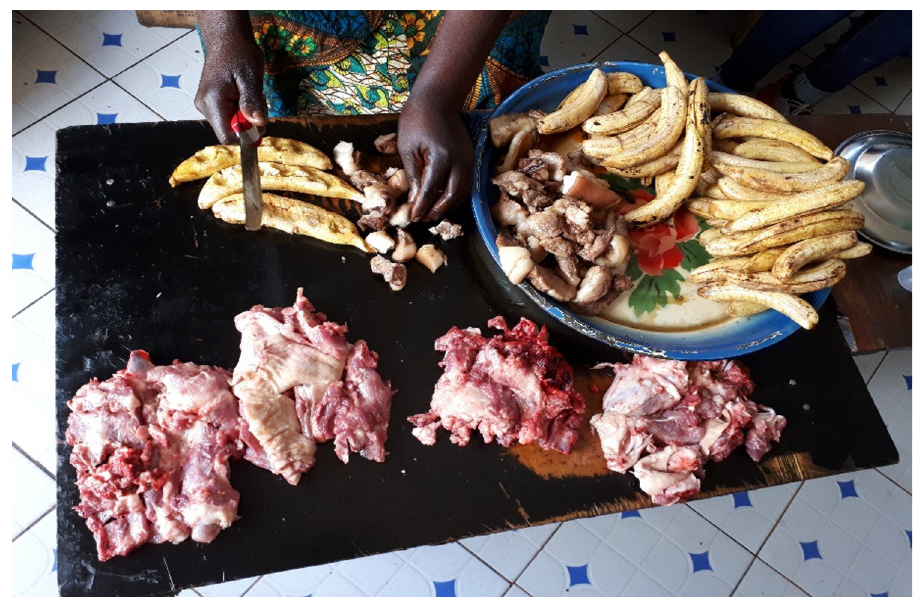
Fig 3. A restaurant workstation in Factory Village showing the three types of pork for sale in the restaurant. On the right on the plate, plantains are seen alongside the dipped pork. On the left, the restaurant female cook is cutting the ready-to-serve pork and plantains on the wooden table where also the raw pork is located (in front).